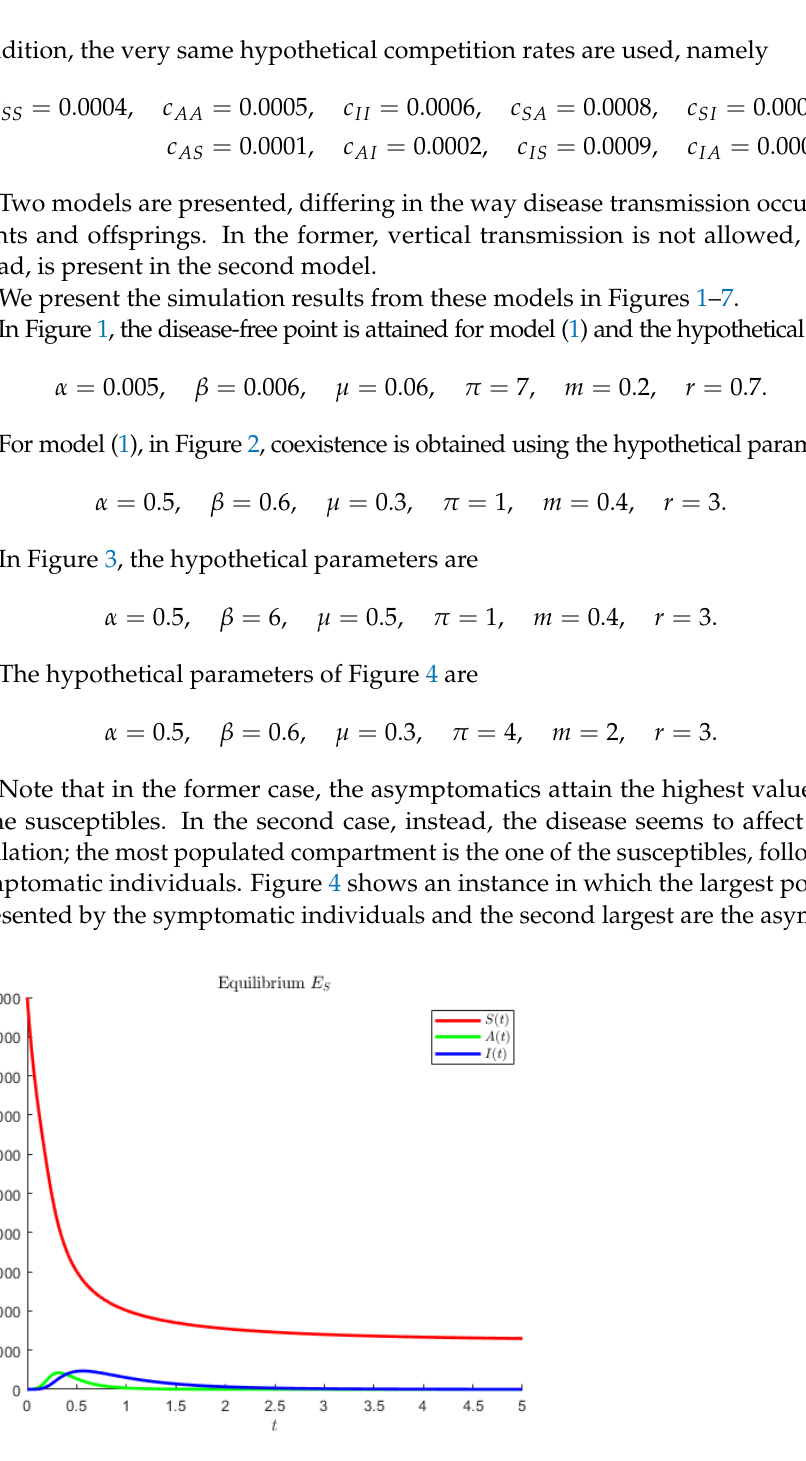
Figure 1. Disease-free point for model (1) obtained with parameter values (52), (51) and initial conditions